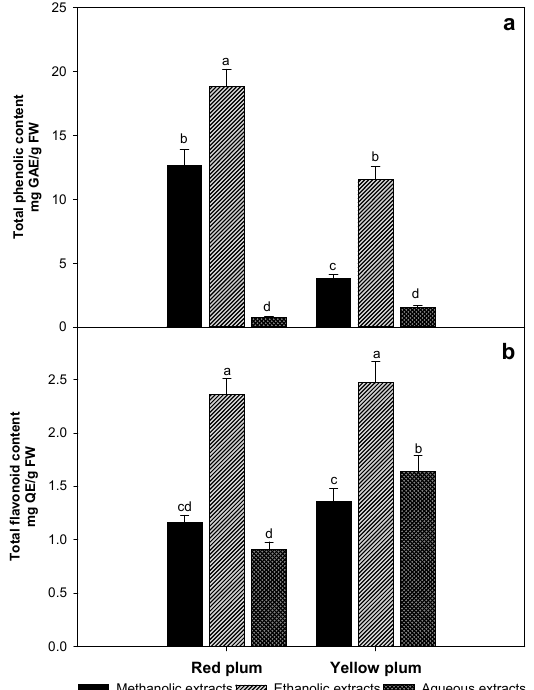
Figure 1. Total phenolic ( a ) and flavonoid ( b ) contents in methanolic, ethanolic and aqueous extracts of red and yellow plum variety. The data are the mean values of at least three determinations (n = 3) ± standard deviation (error bars). Bars with different letters are significantly different ( p ≤ 0.05).